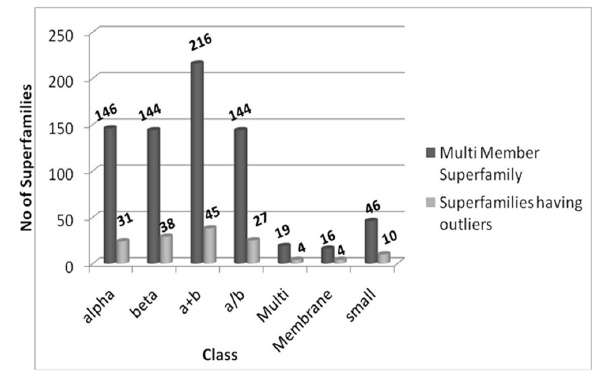
Figure 1. Total number of multi-member superfamilies and superfamilies having structurally deviant domains according to structural class. (Please see Methods for definition of ‘structural